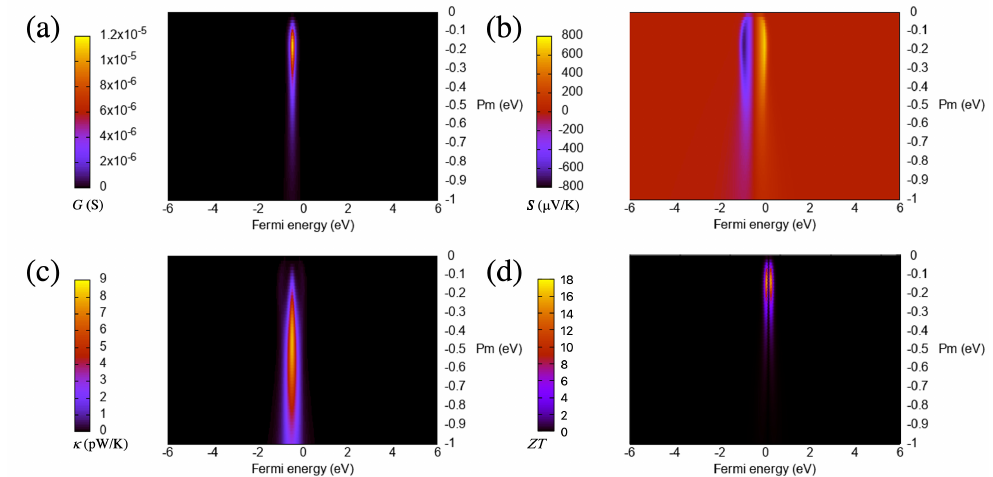
Figure 6. Electrical conductance ( a ), Seebeck coefficient ( b ), electronic thermal conductance ( c ) and figure of merit ( d ) as a function of the Fermi energy and the coupling parameter for the wedge–wedge configuration. The temperature is 300 K.